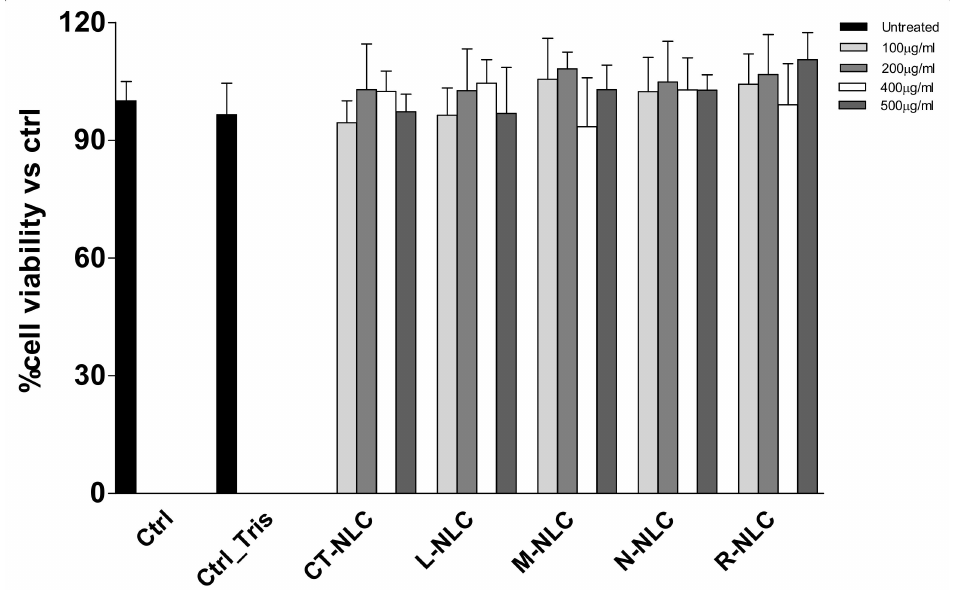
Figure 8. Murine fibroblasts NIH-3T3 viability after 24 h treatment with different concentrations of Tegosoft CT NLC (CT-NLC), Lavandula NLC (L-NLC), Rosmarinus NLC (R-NLC), Mentha NLC (M-NLC), and Neem NLC (N-NLC). All values are mean ± SD of three experiments in triplicate.